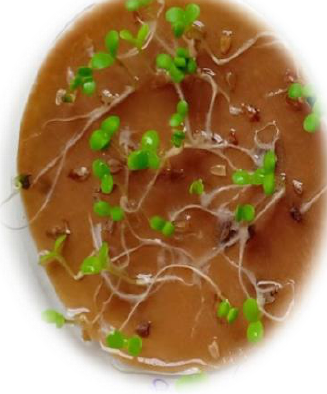
Figure 1. Seeds of the two varieties of Anacyclus pyrethrum (L.) Link considered as germinated .